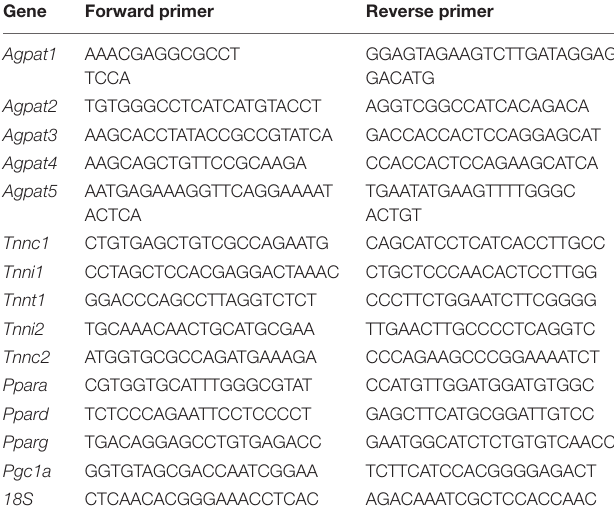
TABLE 2 | List of primers used for